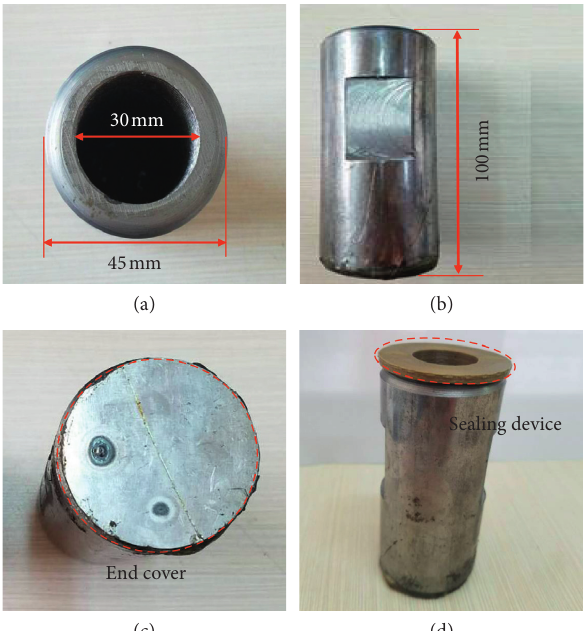
Figure 12: Photographs of the sleeve (steel tube) used in the experiment, showing the sleeve in (a) top view, (b) side view, and (c) bottom view; (d) after assembly of the sealing device.